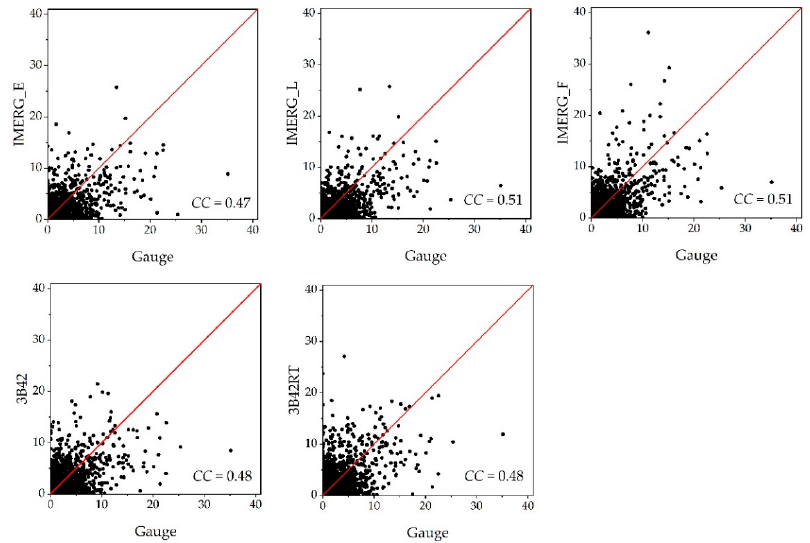
Figure A6. Scatterplots between hourly rainfall gauge observations and satellite precipitation product estimates.